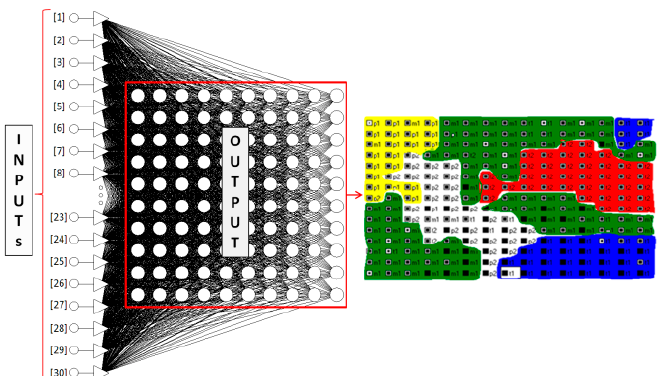
Figure 5. An example of the structure of a Kohonen-type neural network applied as a colour (classificator) separator.